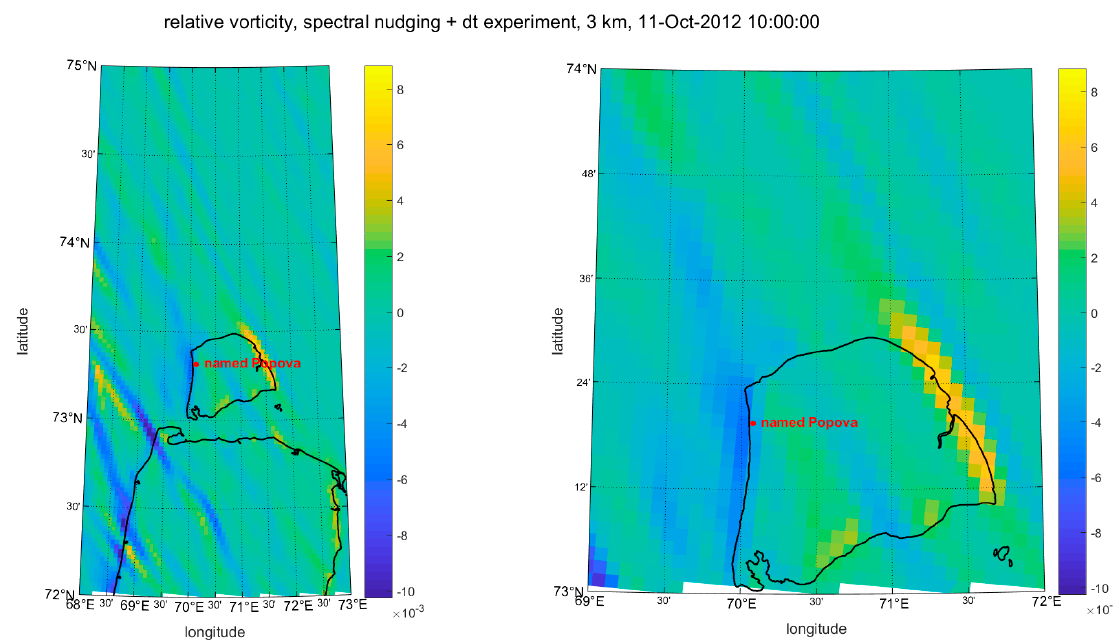
Figure 6. Relative vorticity (10 -3 m/s 2 ) for the *_sn+dt experiment ≈ 3 km grid, on 11 October 2012, at 10:00 GMT, at the named Popova (Belyi Island) station region. The right panel is the enlarged version of the left panel.